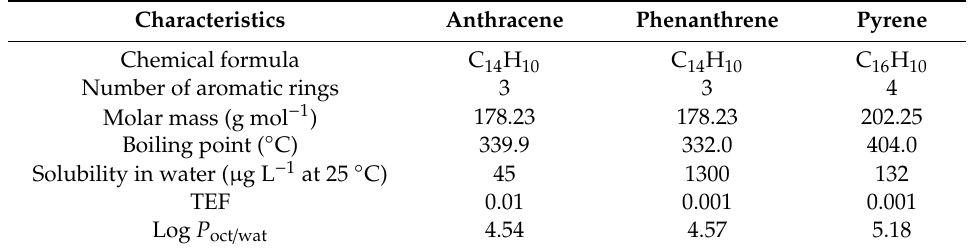
Table 1. Polycyclic aromatic hydrocarbons used to contaminate sand in the biotest.